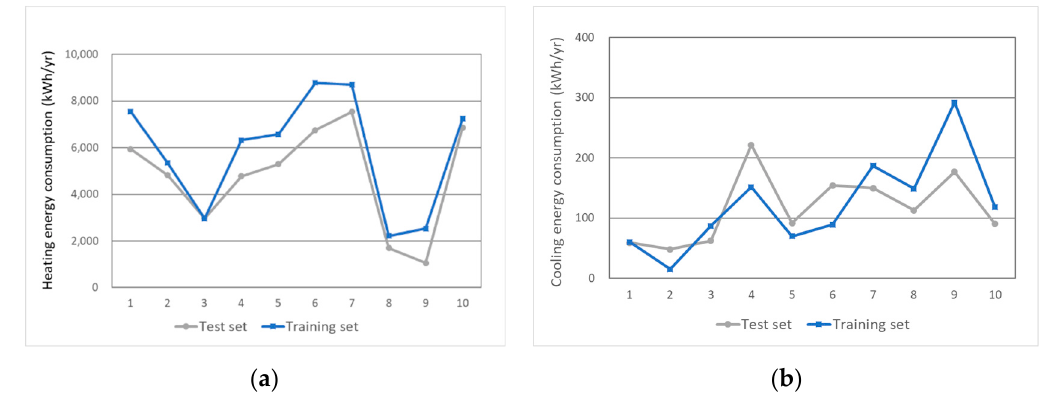
Figure 6. Ten households’ measurement data of test and training sets: ( a ) heating ( b ) cooling.